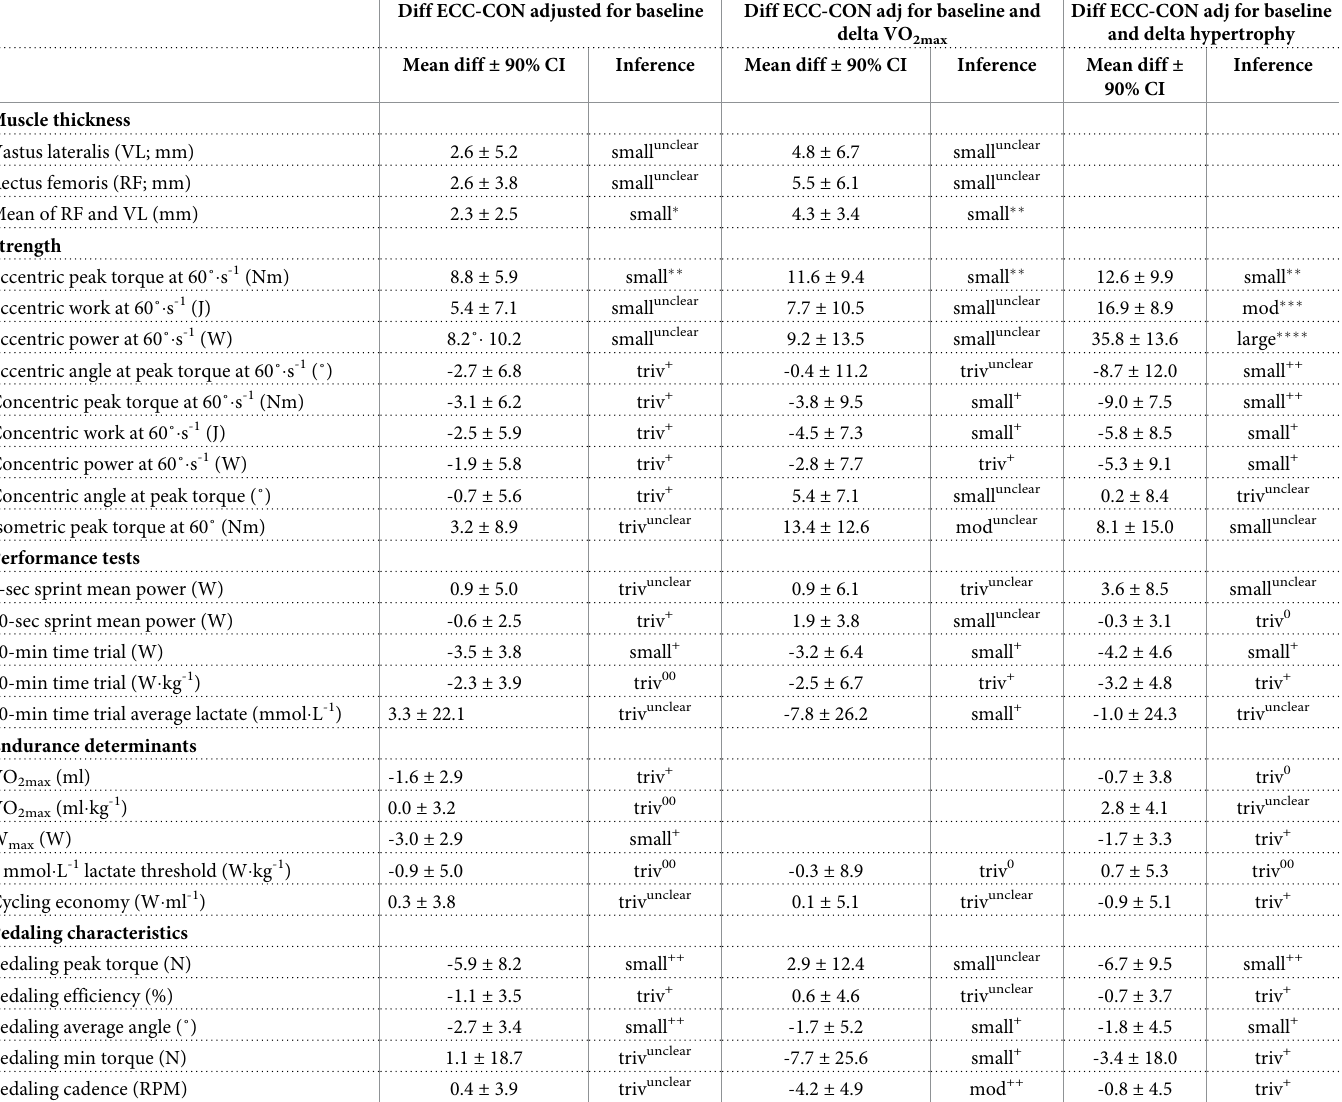
Table 3. Percent difference in changes between groups with magnitude-based inferences when adjusted to baseline, adjusted to baseline and change in VO 2max , or adjusted to baseline and change in muscle